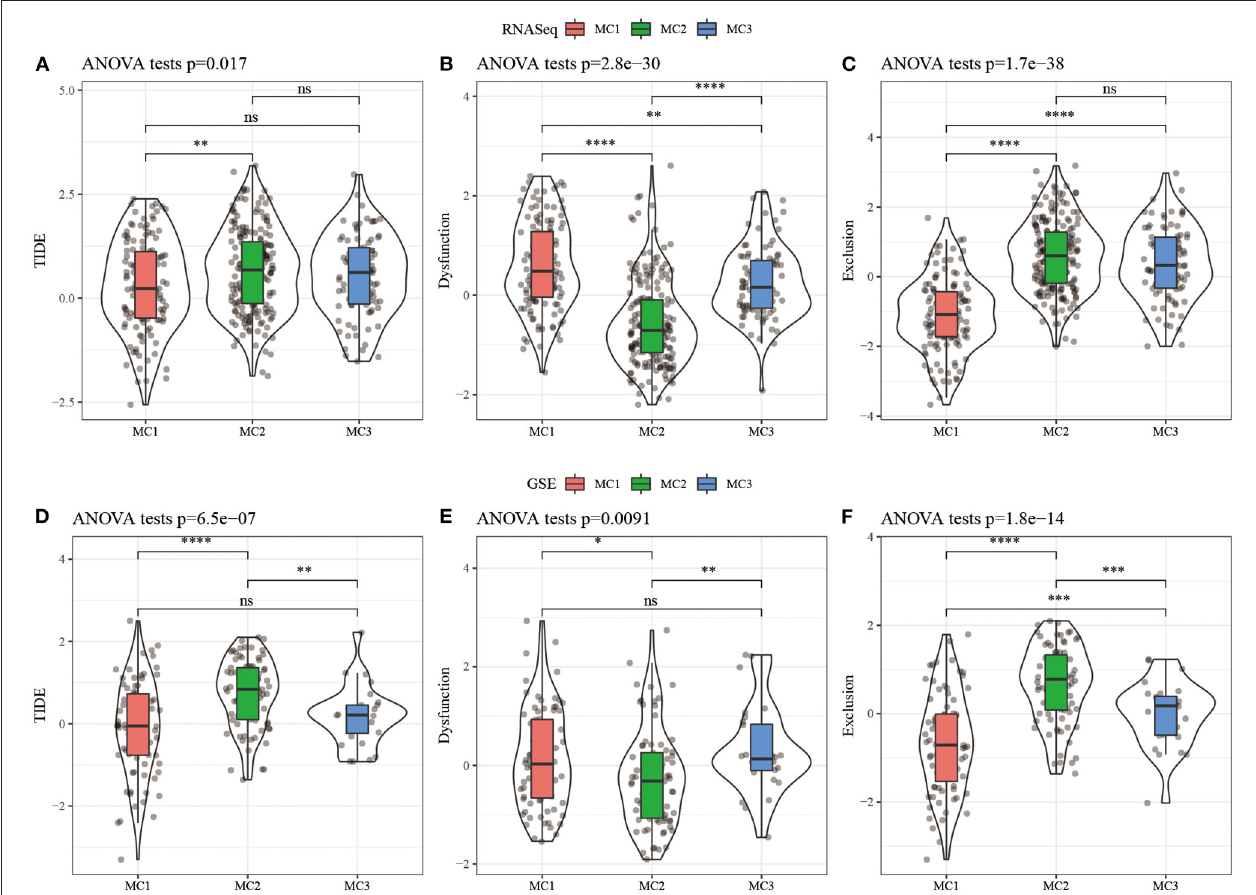
FIGURE 6 | (A) TIDE score difference of different metabolic subtypes of RNASeq; (B) T cell dysfunction score difference of different metabolic subtypes of RNASeq; (C) T cell rejection score difference of different metabolic subtypes of RNASeq; (D) Different metabolic subtypes of GSE TIDE score difference; (E) HCCDB18 different metabolic subtypes of T cell dysfunction score difference; (F) GSE different metabolic subtypes of T cell rejection score difference. ns, no significance. * P < 0.05, ** P < 0.01, *** P < 0.001, **** P <